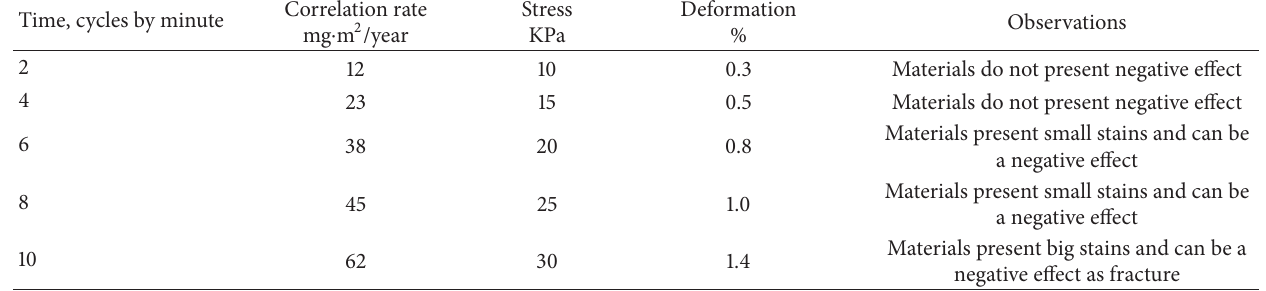
Table 1: Mechanical properties and function analysis of the electromechanical and electronic mechanisms. Time, cycles by minute